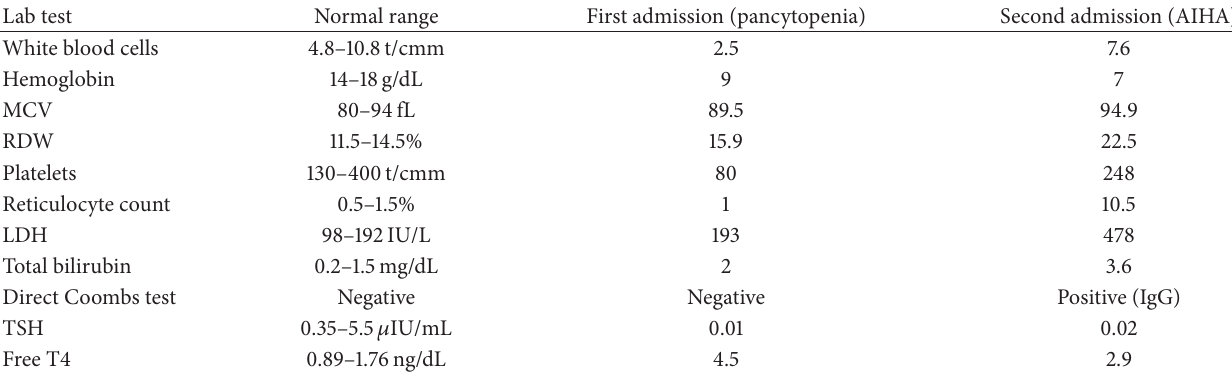
Table 1: Summary of lab results during the first and second hospital